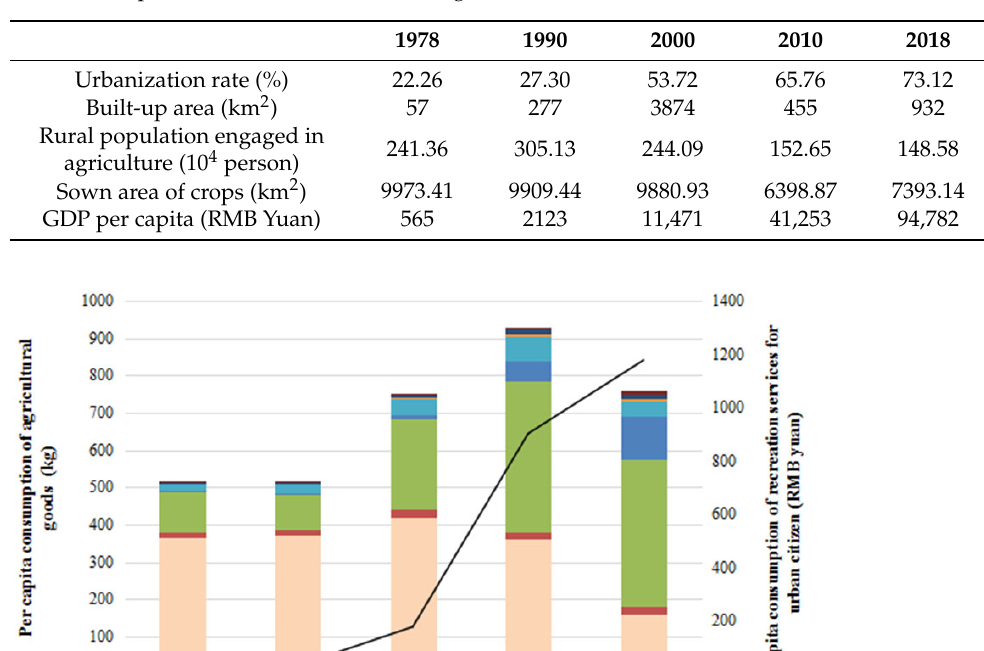
Table 3. The process of urbanization in Chengdu from 1978 to 2018.